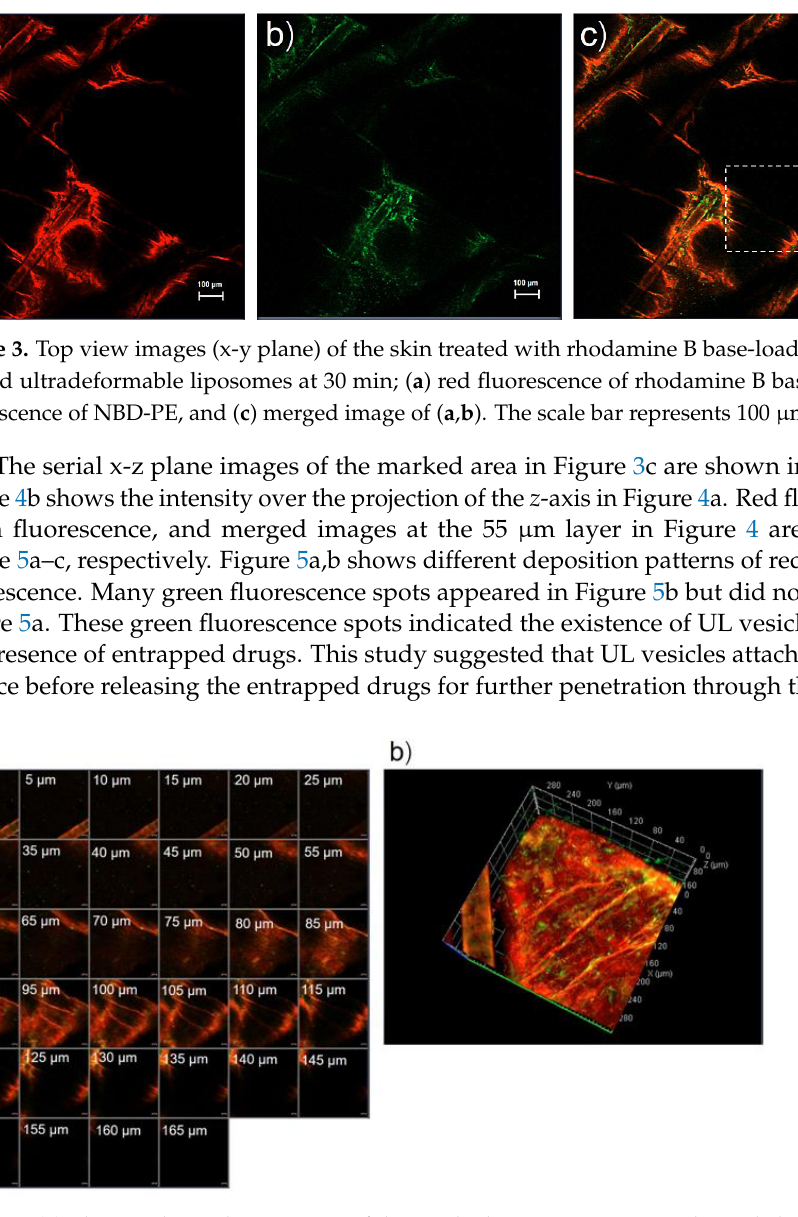
Figure 5. ( a ) Red fluorescence, ( b ) green fluorescence, and ( c ) merged image at the 55 µm layer in Figure 4a. The scale bar represents 20 μm. Cross-sectional images of porcine skin treated with rhodamine B base-loaded NBD-PE-labeled ULs are shown in Figure 6a–c. In Figure 6a, red fluorescence was clearly seen at the hair follicles more than the tissue region, indicating the penetration of UL vesicles via hair follicles. Figure 6b,c reveals green fluorescence, as seen in the white cir- cles, indicating the penetration of UL vesicles into the hair follicles in which the en- trapped drugs were already released to the surrounding tissues. Figure 6b,c also illus- trates the penetration of UL vesicles via hair follicles as a major skin penetration path- way. These findings agreed with a previous study in which ULs with d-limonene pene-